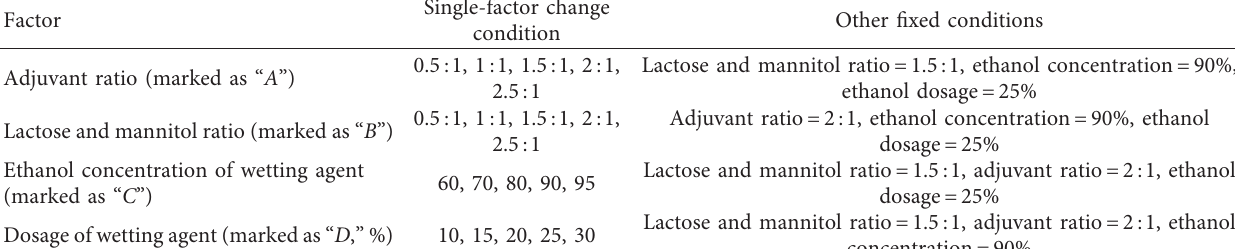
Table 1: The change conditions of single factor.